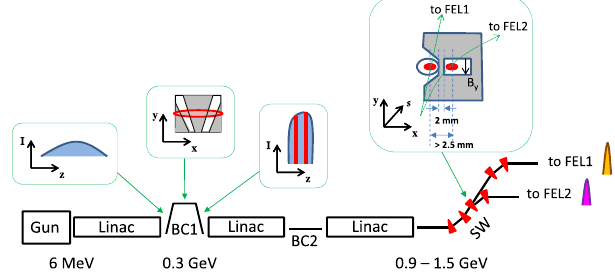
FIG. 1. FEL doubler applied to FERMI (not to scale): Selection of electron beamlets in BC1 with a mask (red slices; blue regions are not transported downstream) and separation in the switchyard (SW) with a septum